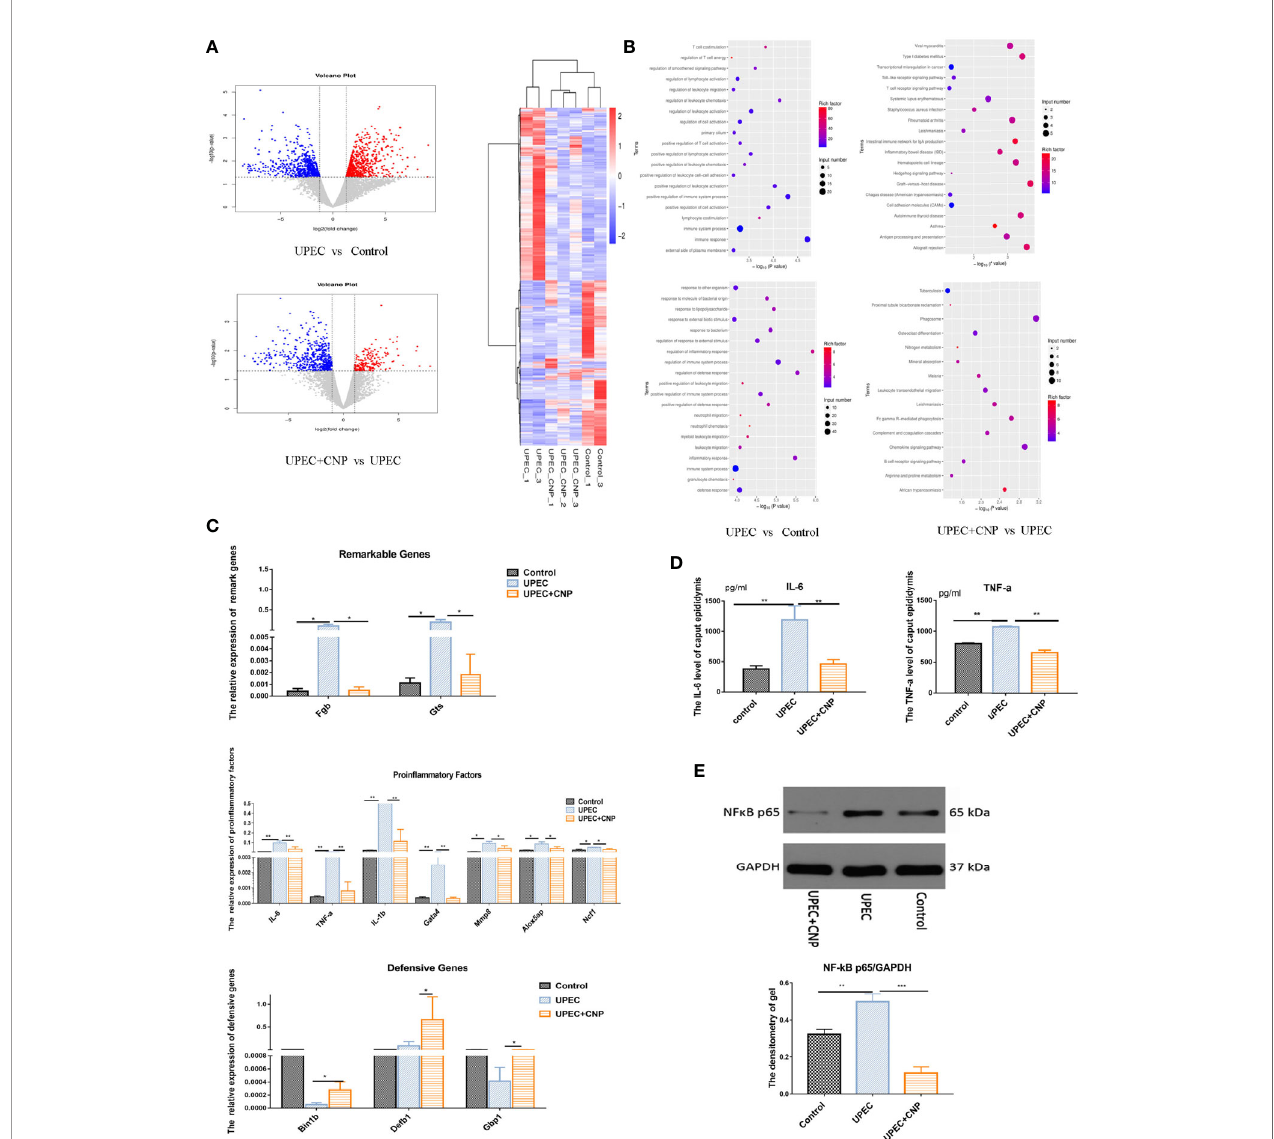
FIGURE 2 | RNA-seq sequencing and veri fi cation of genes. (A) Volcano graph and heatmap; blue represents downregulation, and red represents upregulation. (B) GO analysis and KEGG analysis between each group. (C) Gene veri fi cation with qPCR. (D) The content of IL-6 and TNF-a in caput epididymal fl uid. (E) Expression level of NF-kB protein in caput epididymal tissue and was quanti fi ed in images. (mean ± SD, n = 3, *P < 0.05, **P < 0.01, ***P <